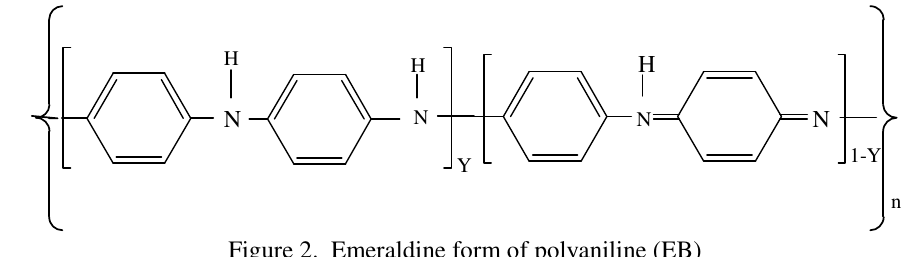
Figure 2. Emeraldine form of polyaniline